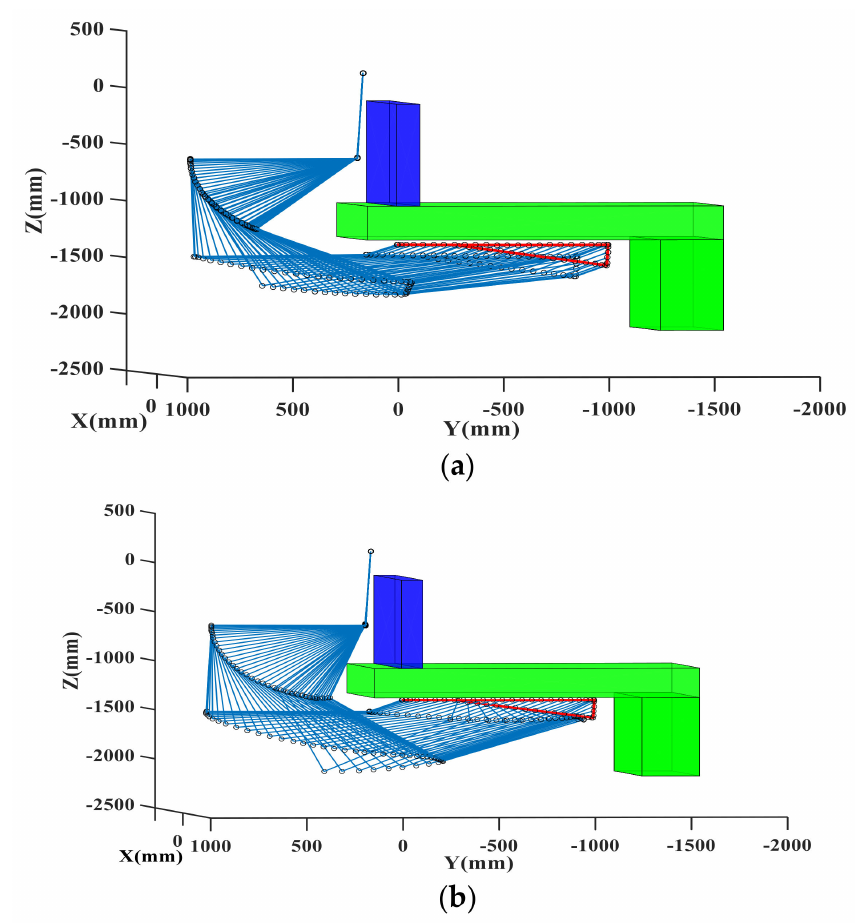
Figure 8. Schematic diagram of the collision-free trajectories of the manipulator. ( a ) Without opti- mization, ( b ) With